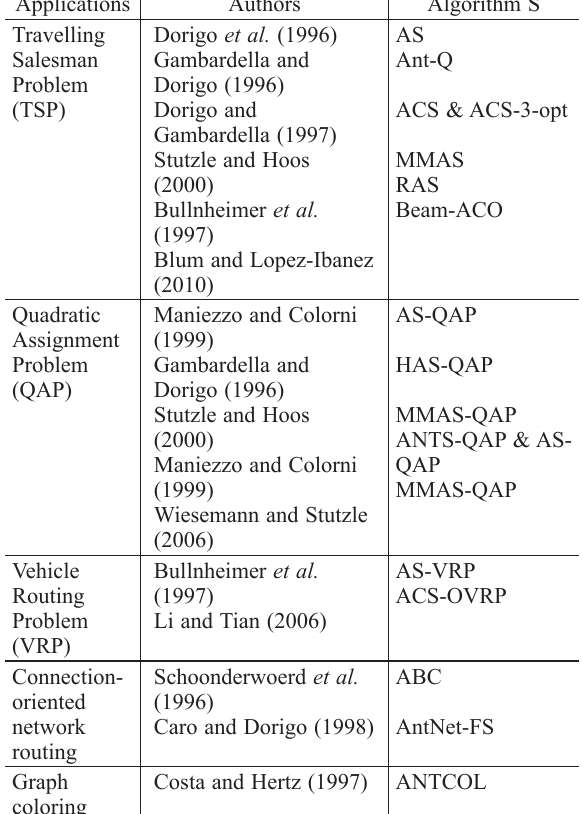
Table 1. Various applications of ACO